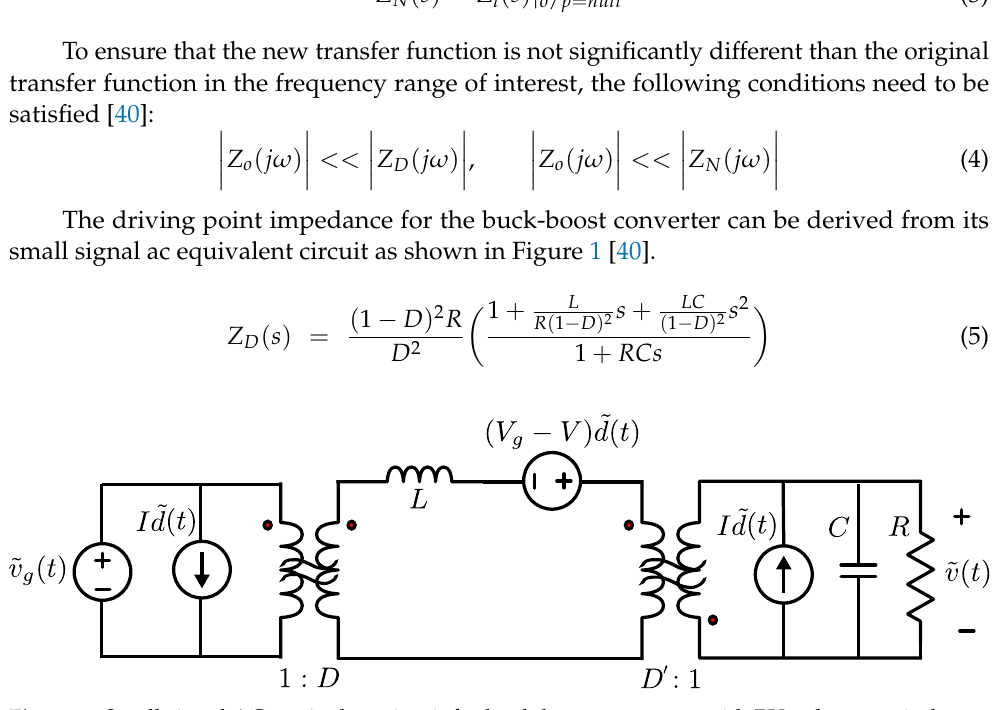
Figure 1. Small signal AC equivalent circuit for buck-boost converter with PV voltage v g , inductor L ’s current i , capacitor C , load resistor R ’s voltage v and control input d where D (cid:48) = 1 − D . ˜ refers to the small signal variation in the steady state variables marked in capital